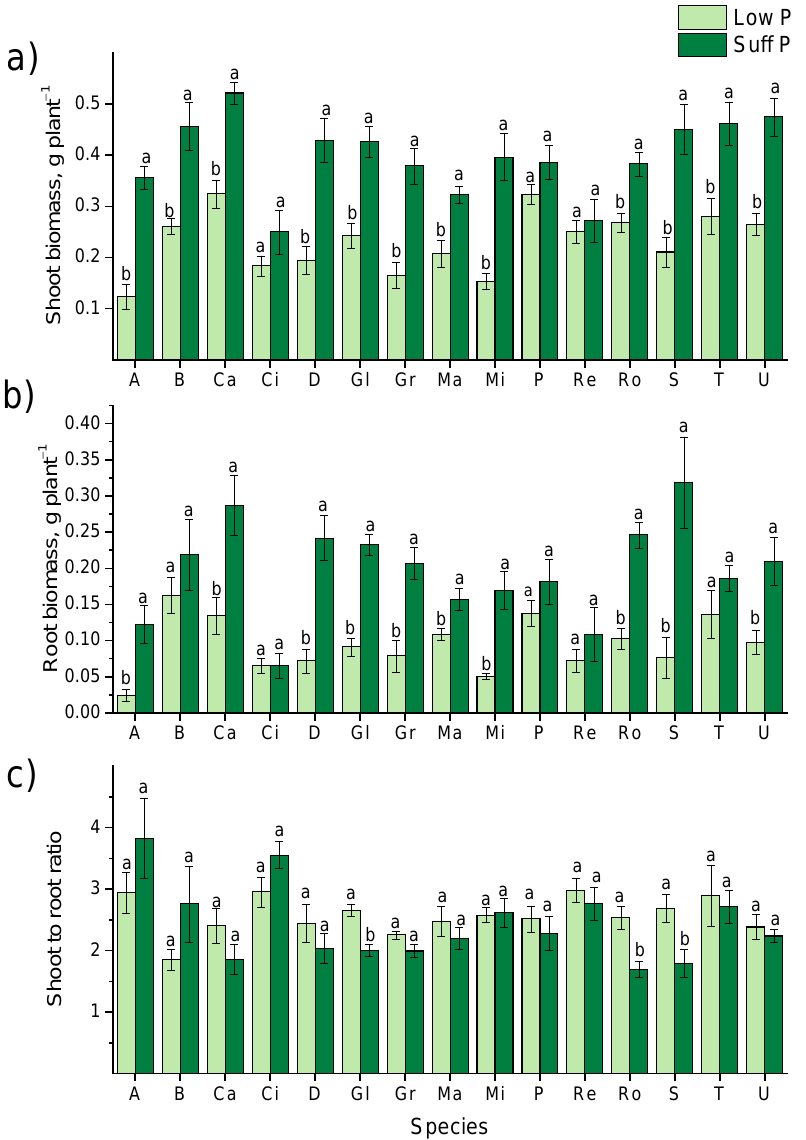
Figure 1. Shoot ( a ) and root ( b ) biomass production, and shoot-to-root ratio ( c ) of fifteen eucalypt species grown under low (Low P, clear color) and sufficient (Suff P, dark color) phosphorus concen- trations. Different letters indicate significant differences between low and sufficient P concentrations within each species by the Tukey test ( p < 0.05). Species abbreviations: A— E. acmenoides , B— E. brassiana , Ca— E. camaldulensis , Ci— C. citriodora , D— E. deanei , Gl— E. globulus , Gr— E. grandis , Ma— C. maculata , Mi— E. microcorys , P— E. pellita , Re— E. resinifera , Ro— E. robusta , T— E. tereticornis , S— E. saligna , U— E. urophylla